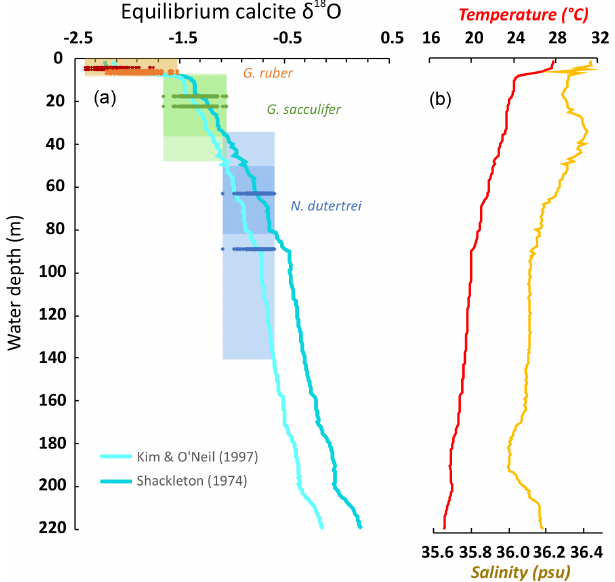
Figure 5. δ 18 O of equilibrium calcite (a) calculated from the CTD temperature and salinity profile at station 11 (von Rad, 2013) (b) with projected depth ranges of G. ruber 400–500µm (red), G. ru- ber 315–400µm (orange), G. sacculifer 315–400µm (green), and N. dutertrei 315–400µm (blue). We show estimated values using both the original paleotemperature equation of Shackleton (1974) (dark teal) and Kim and O’Neil (1997) (turquoise). Horizontal ranges show the measured δ 18 O values of each species between 5.4 and